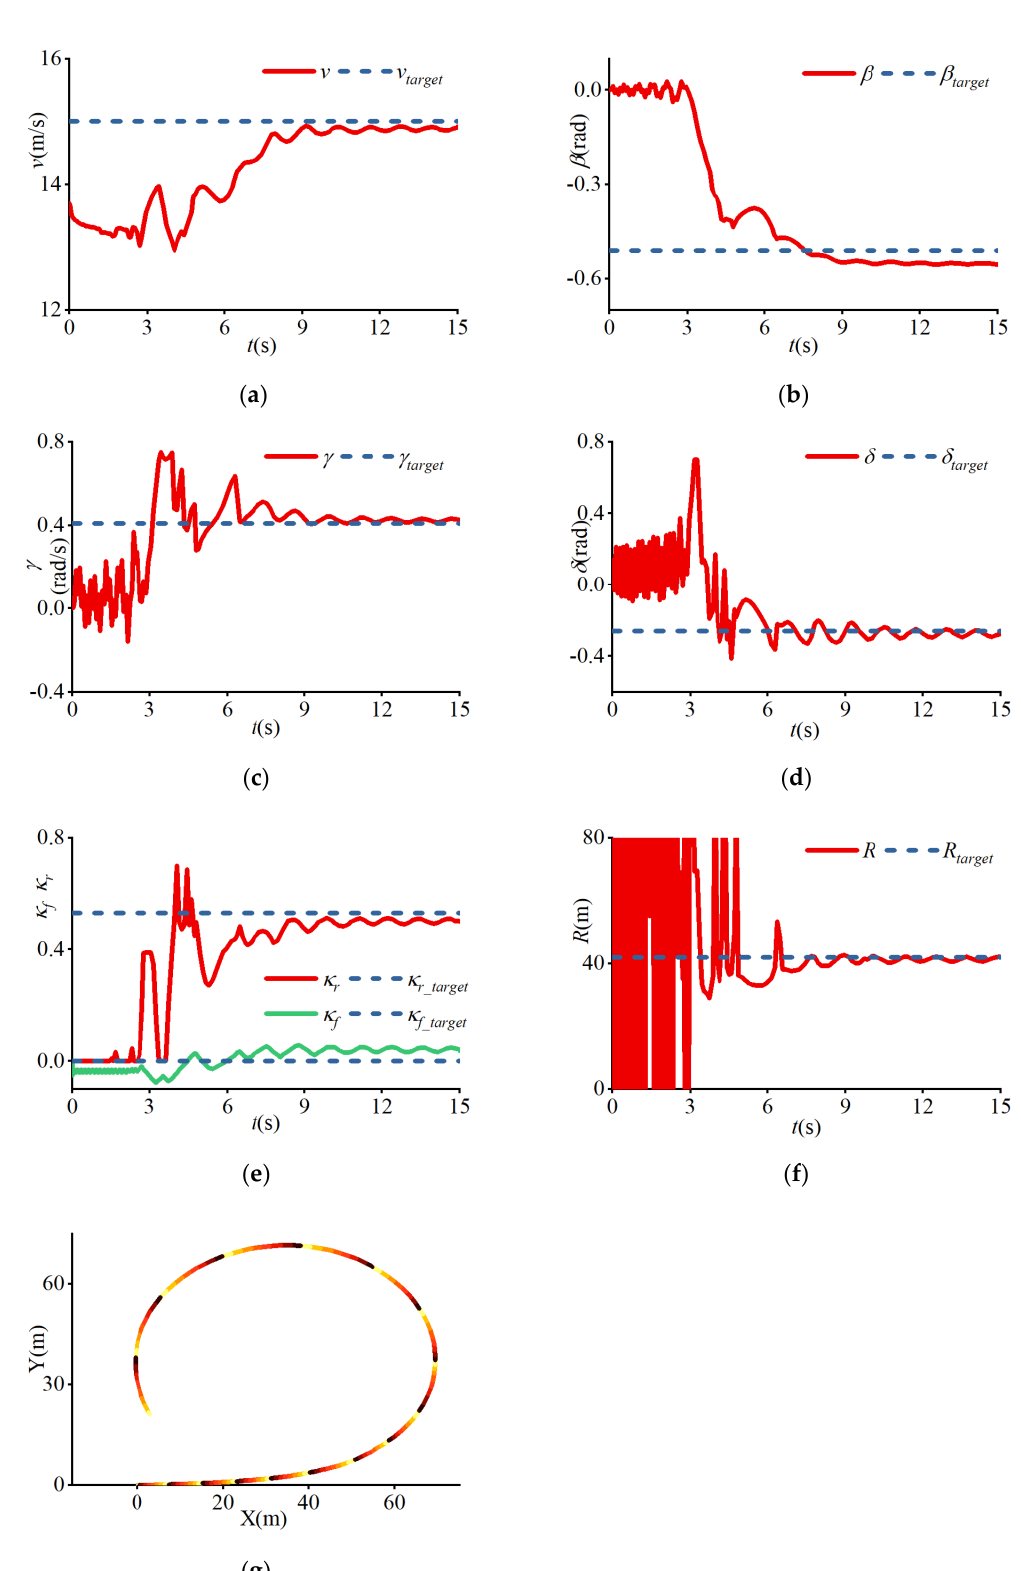
Figure 9. The simulation result with the 9 m/s original velocity and the target group (d): ( a ) the velocity; ( b ) the sideslip angle; ( c ) the yaw rate; ( d ) the steering angle; ( e ) the TYDEX longitudinal slip ratios of the front and rear tires; ( f ) the radius of the motion curve; ( g ) the motion curve of the vehicle. All continuous lines suggest the simulation results, while the dashed lines suggest the targets.